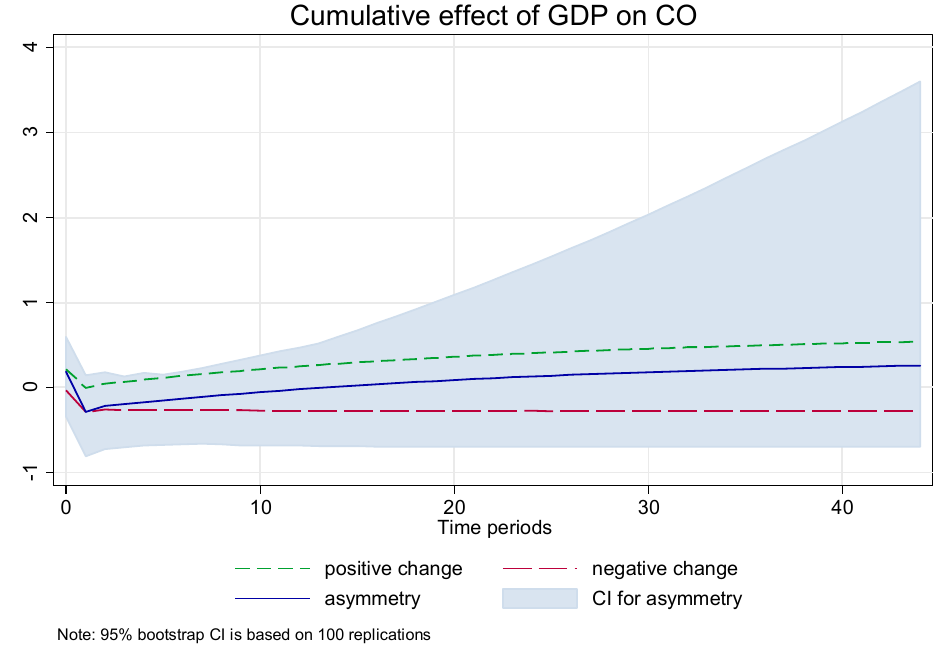
Figure A8 . Cumulative effect of GDP on CO.